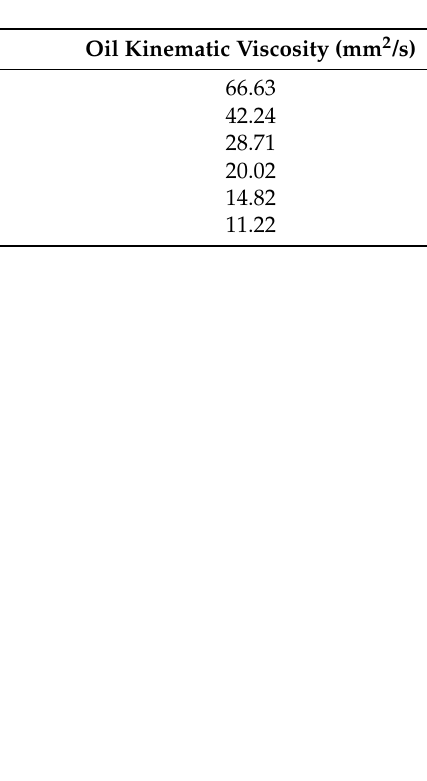
Table 6. Oil properties at different temperatures.